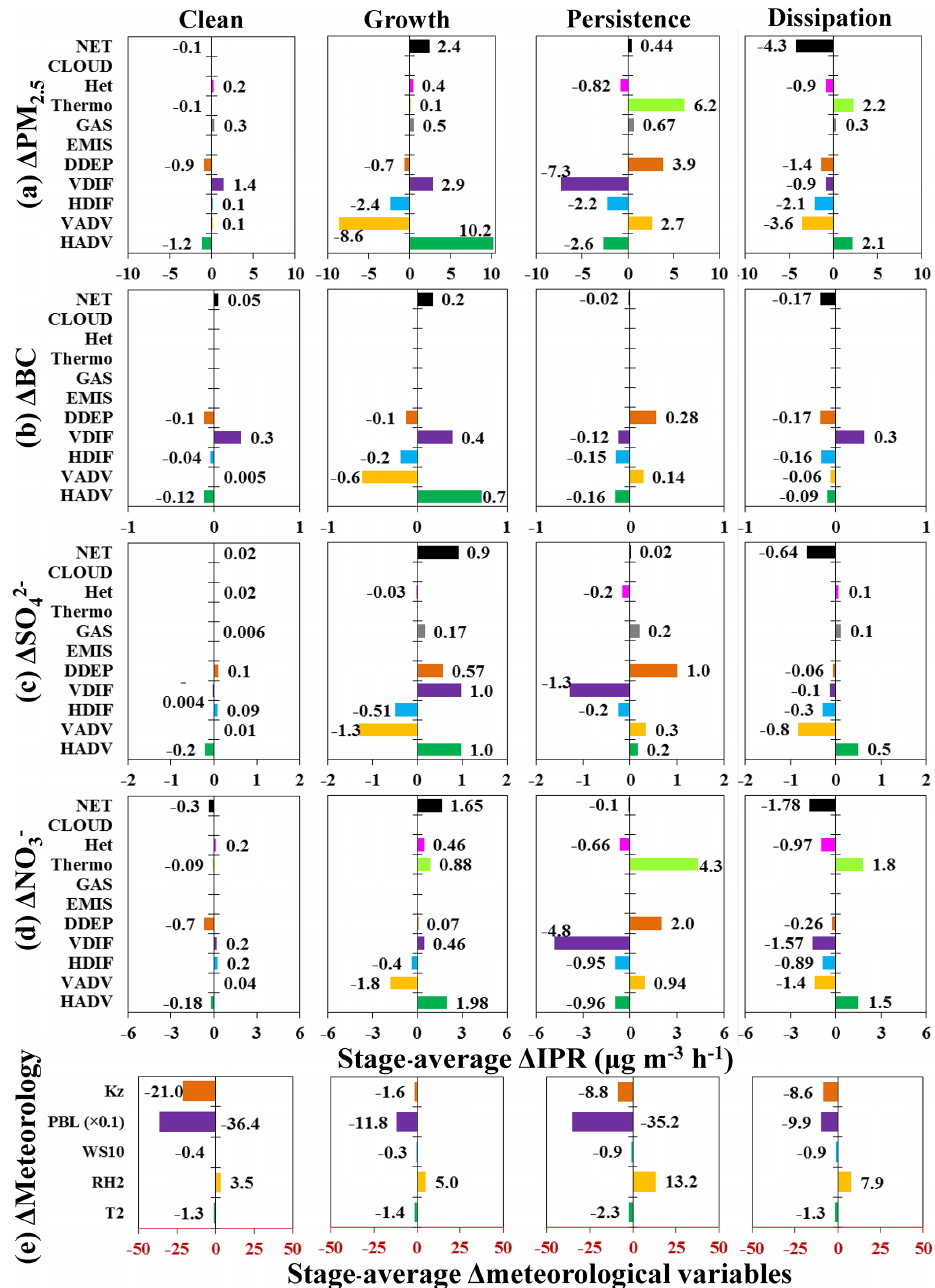
Figure 11. Same as Fig. 10 but for the second haze episode (1–4 March). The division of the four stages is the same as that in Fig. 9.